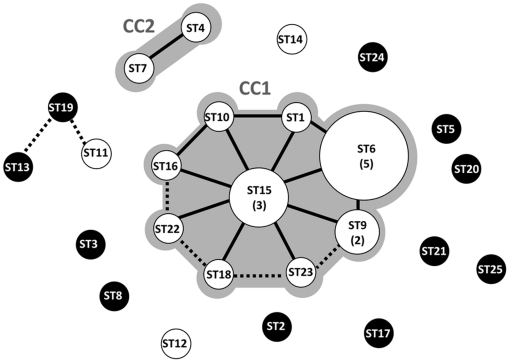
eBURST analysis of 32 L. lactis subsp. lactis strains.White circles correspond to dairy strains, and black circles to non-dairy strains. The size of the circles is proportional to the number of strains belonging to each ST (indicated in brackets). Clonal complexes (CC) are indicated in gray. Solid lines link SLV (Single Locus Variant, i.e. STs sharing five of the six loci). Dotted lines link DLV (Double Locus Variant, i.e. STs sharing four of the six loci). The ST15 is predicted to be the ancestor genotype of the major CC.